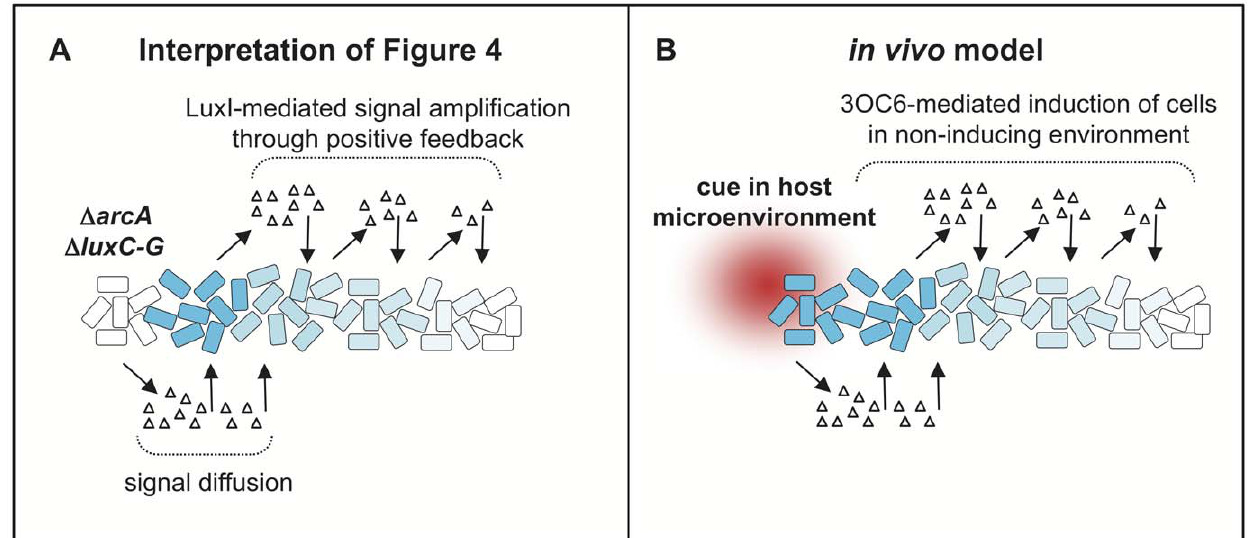
Figure 6. Models of how subpopulations with heterogeneous Arc status could coordinate population-wide responses. Triangles indicate 3OC6 pheromone, white cells indicate no luminescence, and blue cells indicate luminescent cells. Panel A illustrates an interpretation of the data in Figure 4C, and panel B illustrates how similar signaling might occur in the host environment. In panel B we propose that even if only a subset of cells in the light organ experience physiological changes that silence ArcB kinase activity, this could result in loss of ArcA-dependent repression of lux followed by increased production of 3OC6 pheromone signals. This 3OC6 could then diffuse into neighboring ArcA-repressed cells to initiate positive feedback regulation of lux, thereby inducing luminescence in a population-wide response to conditions sensed by ArcB in a sub-population of symbionts.